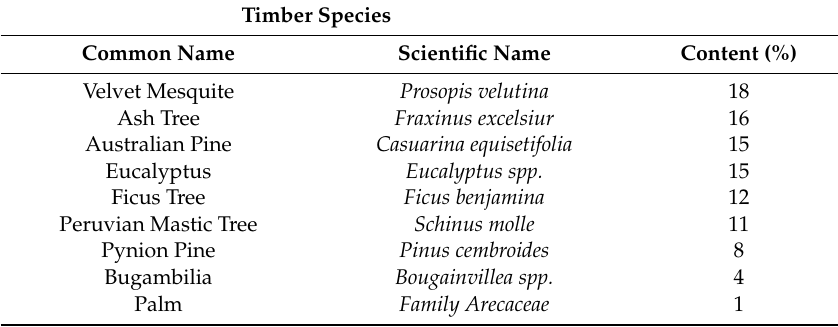
Table 1. Woody composition of sample 2, municipal composting.